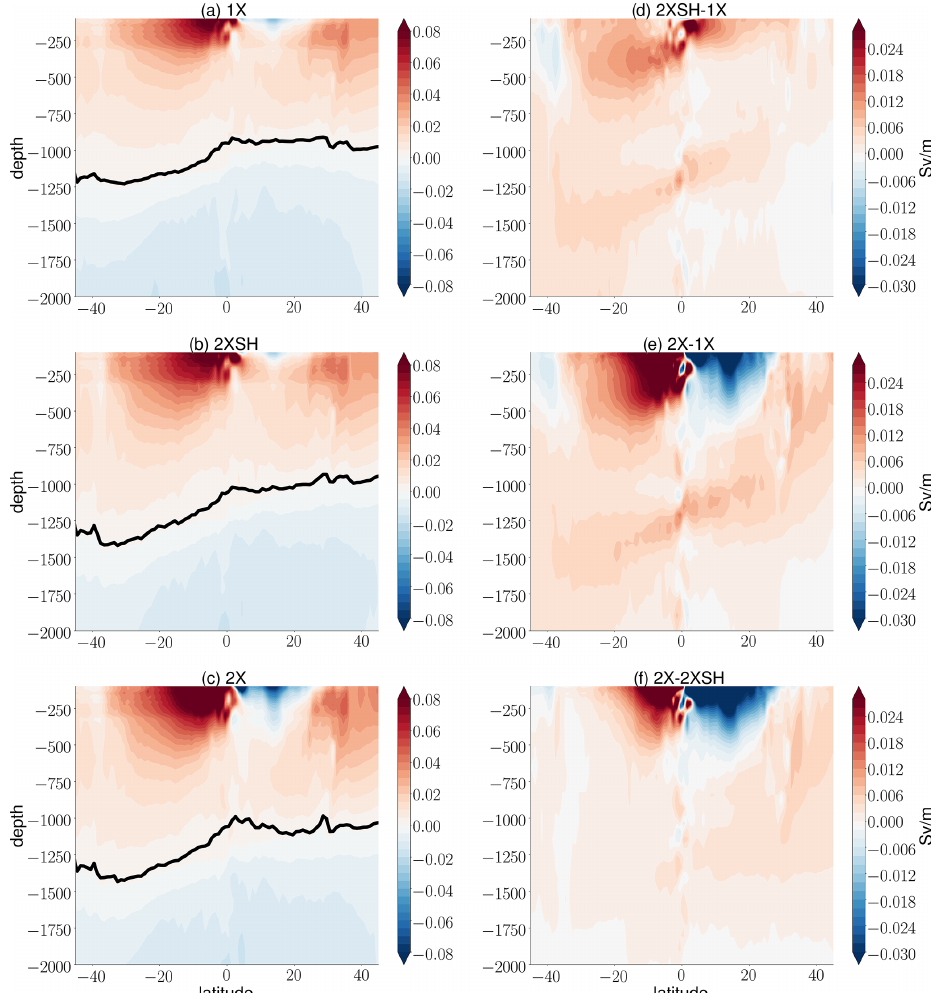
Figure 7. The time-mean (1991–2010) vertical derivative of the AMOC streamfunction ∂ψ in the (a) 1X experiment, (b) 2XSH experiment, ∂z and (c) 2X experiment. We further show the difference in ∂ψ between the (d) 2XSH and 1X experiments, (e) the 2X and 1X experiments, ∂z and (f) the 2X and 2XSH experiments. The black line in (a) – (c) represents the level of no motion η ψ . We exclude the surface Ekman